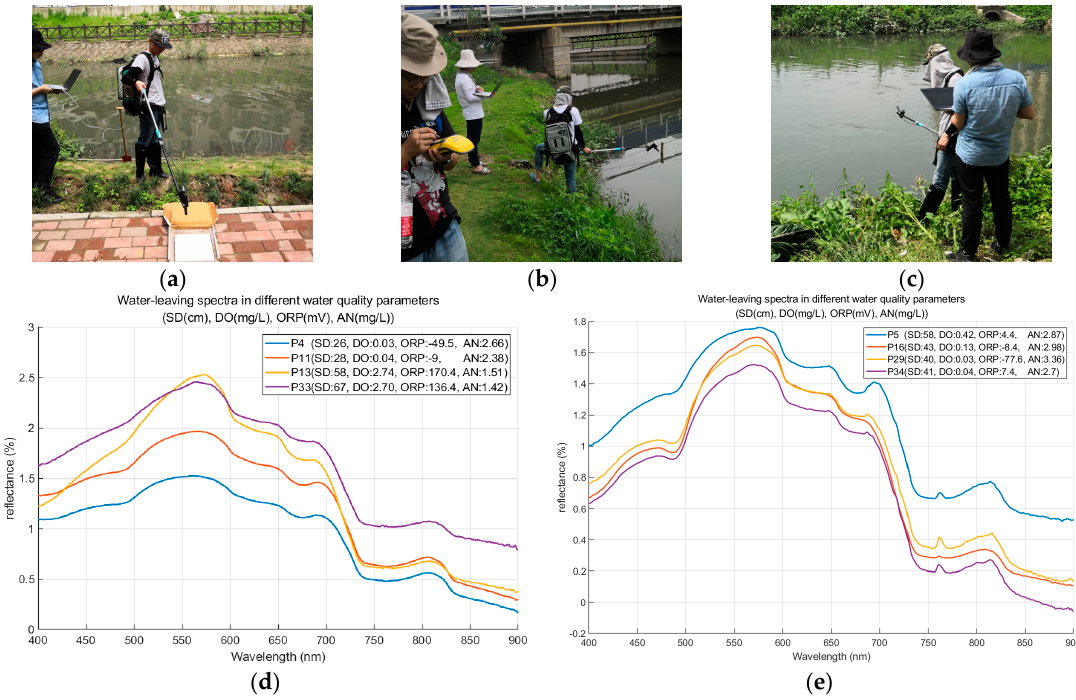
Figure 3. The in-situ measurements of spectral data using ASD device. ( a ) standard board correction; ( b ) spectra above the water surface; ( c ) sky spectra; ( d ) water-leaving spectra in Shahu Port; ( e ) water-leaving spectra in Xunsi River.